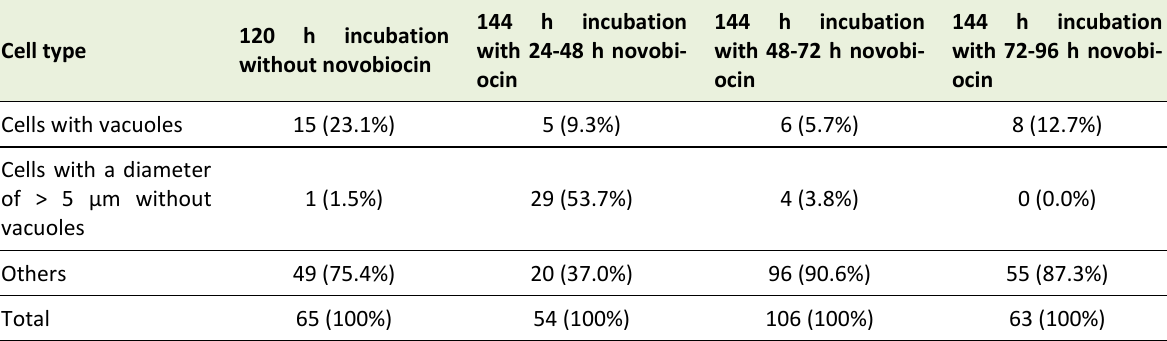
TABLE 2. Number of cells with vacuoles and cells with a diameter of > 5 μm without